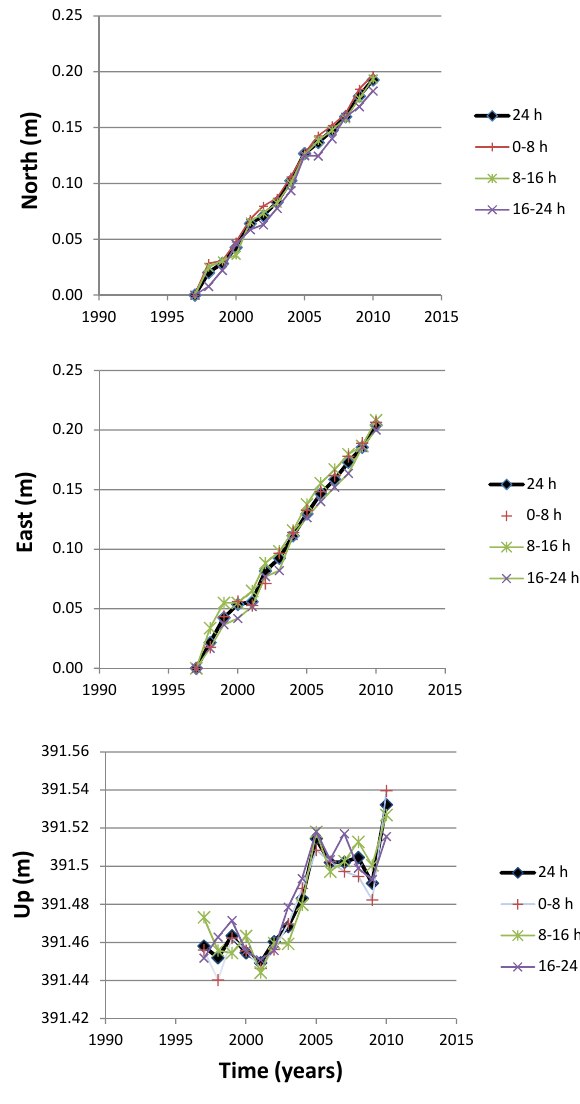
Figure 2. Comparison of the crustal motion using the results of short sessions and 24h solutions for the station